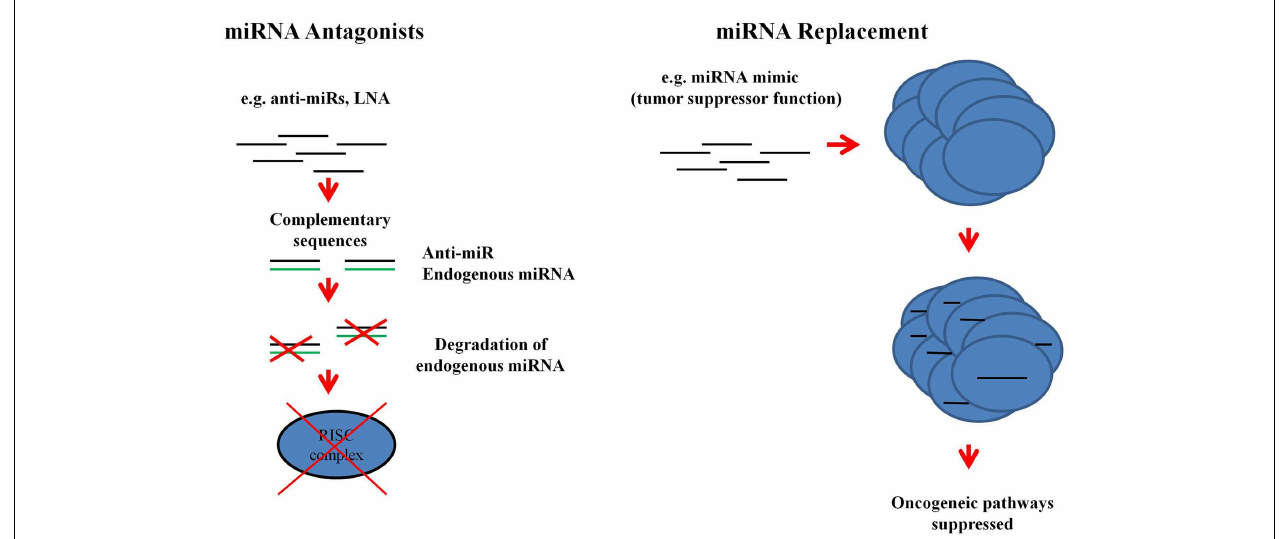
of function of the endogenous miRNA prevents it being processed by RISC. MiRNA mimics are also oligonucleotides, but they replace the lost function due to the disease state of the cell [adopted from Ref.